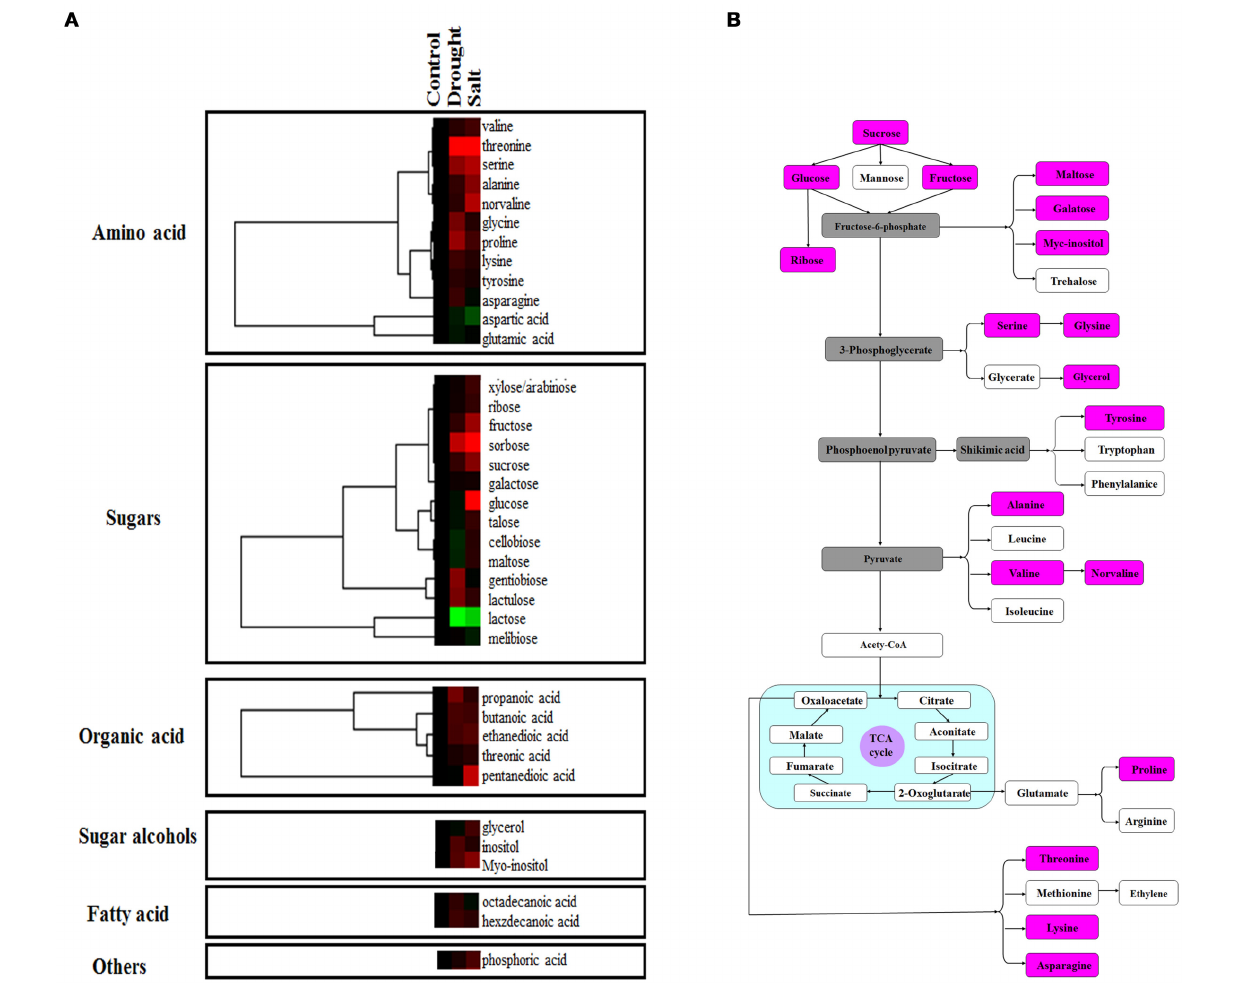
FIGURE 6 | Effects of drought and salt stresses on metabolites in bermudagrass. (A) Hierarchical cluster analysis of 37 compounds affected by drought and salt stress conditions in bermudagrass. The resulting tree figure was obtaining using the Java Treeview and the CLUSTER software package. The metabolites that were shown in panel (B) were indicated with rose red colors. (B) Assignment of the 18 metabolites studied to pathways. A total of 18 metabolites were indicated in boxes with rose red colors, and the concentrations of these metabolites were shown in Table